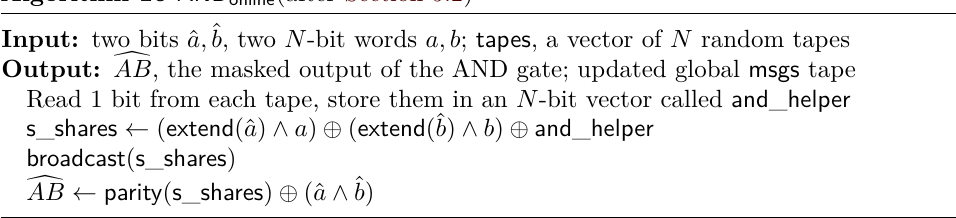
Algorithm 16 AND online (after Section